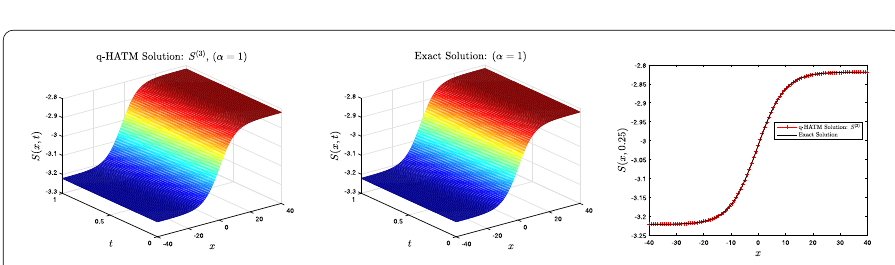
Figure 2 q-HATM vs exact solution when (cid:2) = –1, k = η = 0.1, r = –1.5, p = 1.5, and n = 1 for Example 4.1